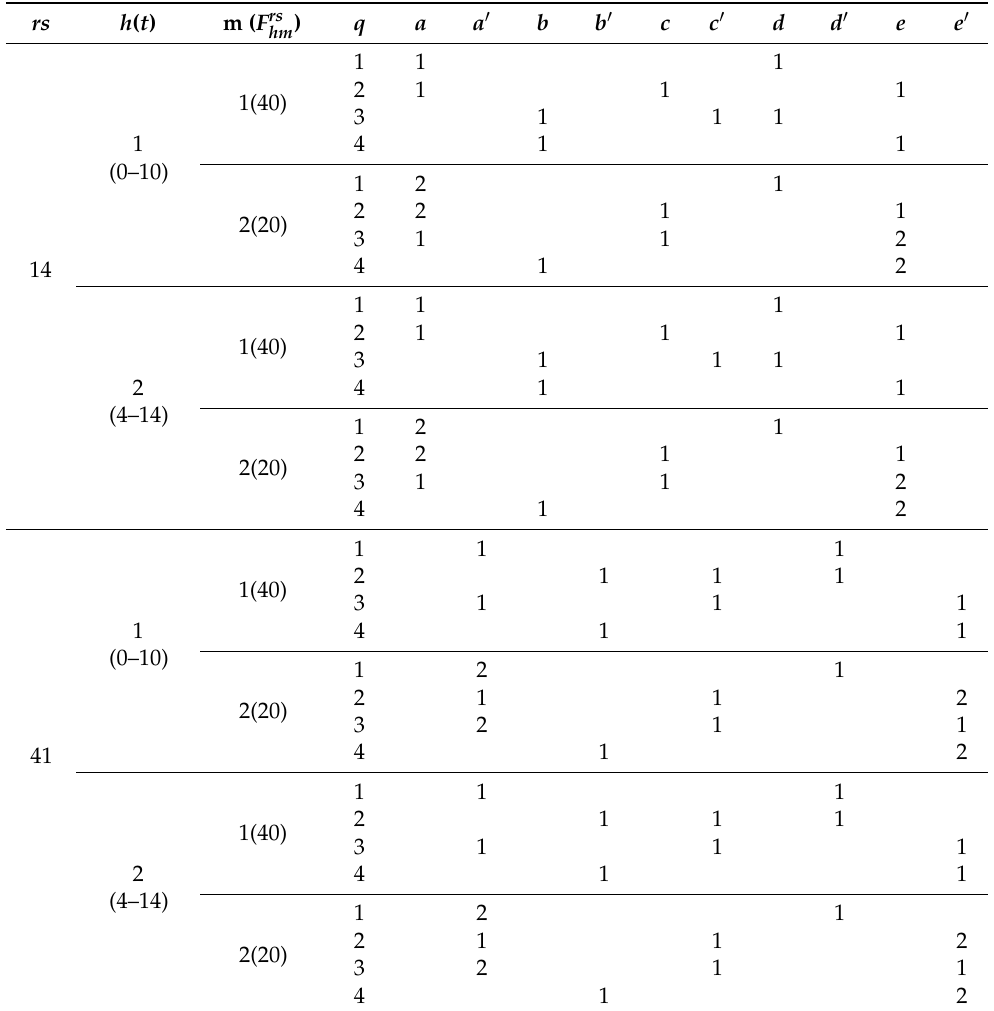
Table 6. Link-path incidence